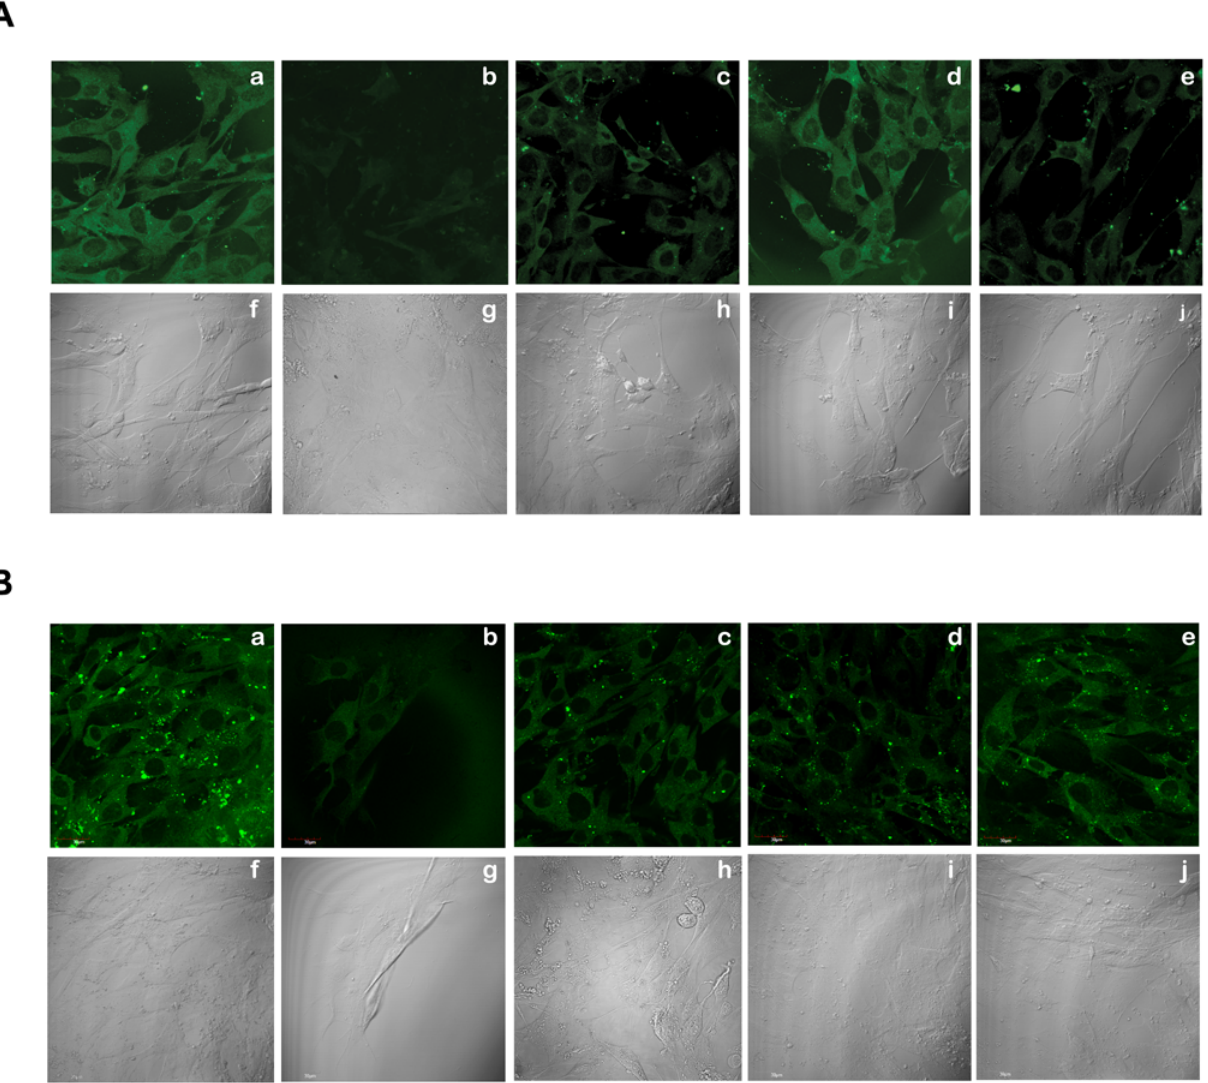
Fig 6. Specific Binding Of Peptides P4 And P8 To Cell-Surface APP By Confocal Microscopy. Biotinylated P4 (A) and P8 (B) were added to APP- transfected fibroblasts (panels a) or untransfected APP-null cells (panels b) and showed binding only to APP-expressing cells. Panels c in A and B show that pre-treatment of the biotinylated peptides with APP significantly reduced their binding to APP-expressing cells, compared to the untreated peptides in panels a. In A, panel d, treatment of APP-expressing cells with excess unbiotinylated P8 did not significantly alter the fluorescence observed when these cells were then treated with biotinylated P4. However, in B, panel d, when the APP-expressing cells were treated with biotinylated P8 following the same treatment, the fluorescence signal was significantly diminished compared to panel a. Similarly, when APP-expressing cells were pre-treated with excess unbiotinylated P4 prior to treatment with the biotinylated peptides, the binding of biotinylated P4 (A, panel e) but not biotinylated P8 (B, panel e) was